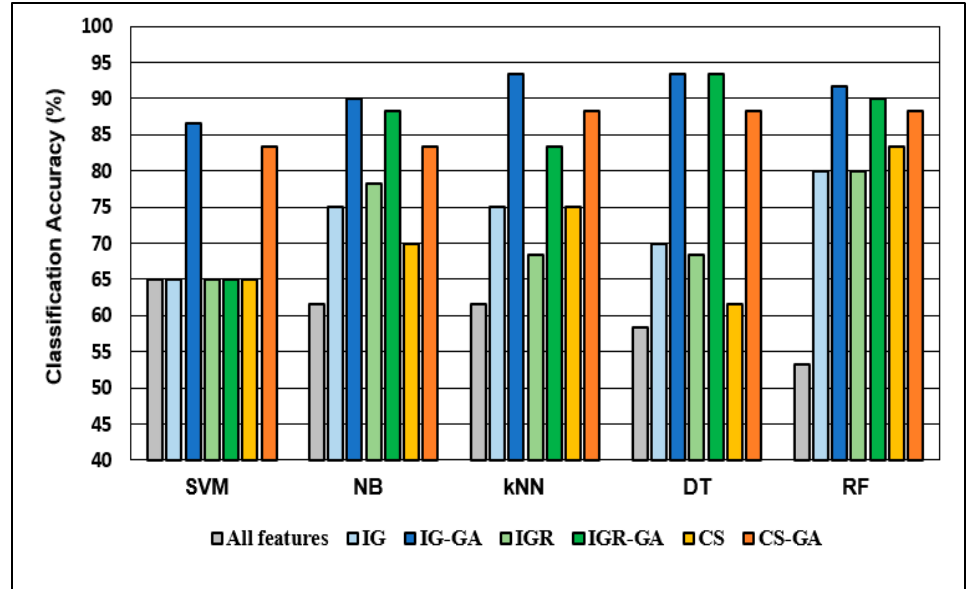
Figure 4. The accuracy comparison of classifiers using all features, the features selected only by filters methods, and the features selected by the proposed hybrid filter-GA methods on the Lung Cancer dataset.